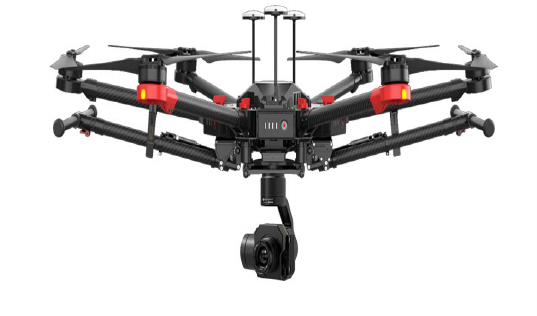
Figure 1. UAV model of DJI Thermal Matrice 600.